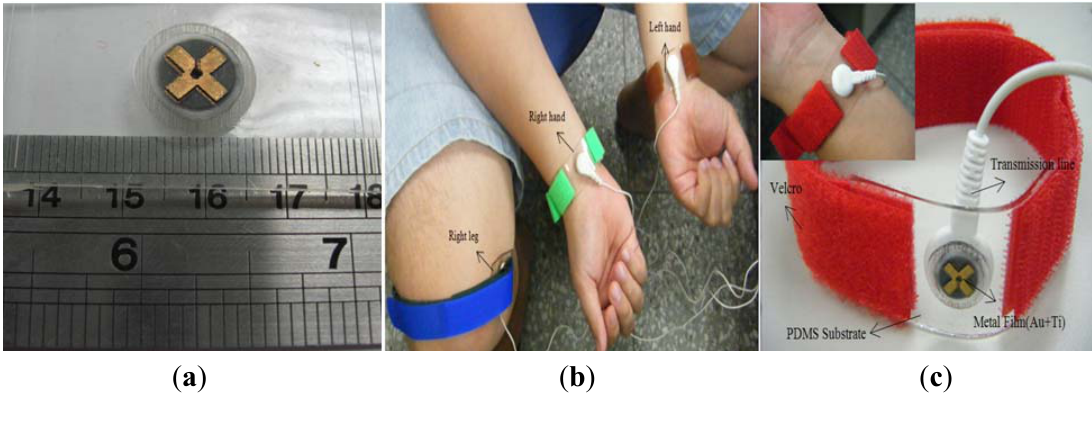
Figure 6. ( a ) Picture of fabricated electrode ( b ) The FPDE placed on body for measurements ( c ) Package of FPDE.